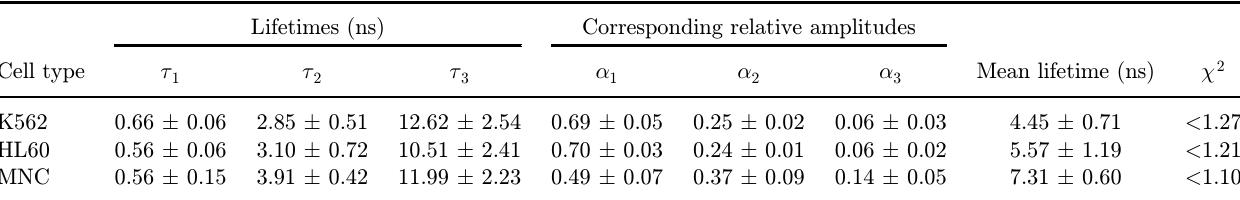
Table 1. Lifetime data determined by ¯tting the time-resolved auto°uorescence spectra ( n ¼